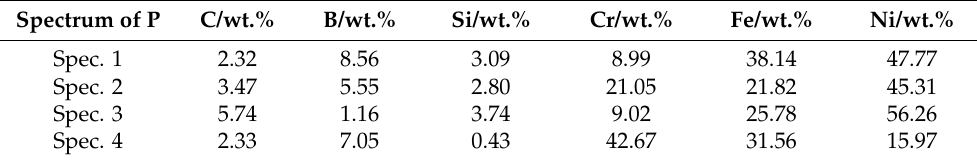
Table 2. EDS results of the coating.